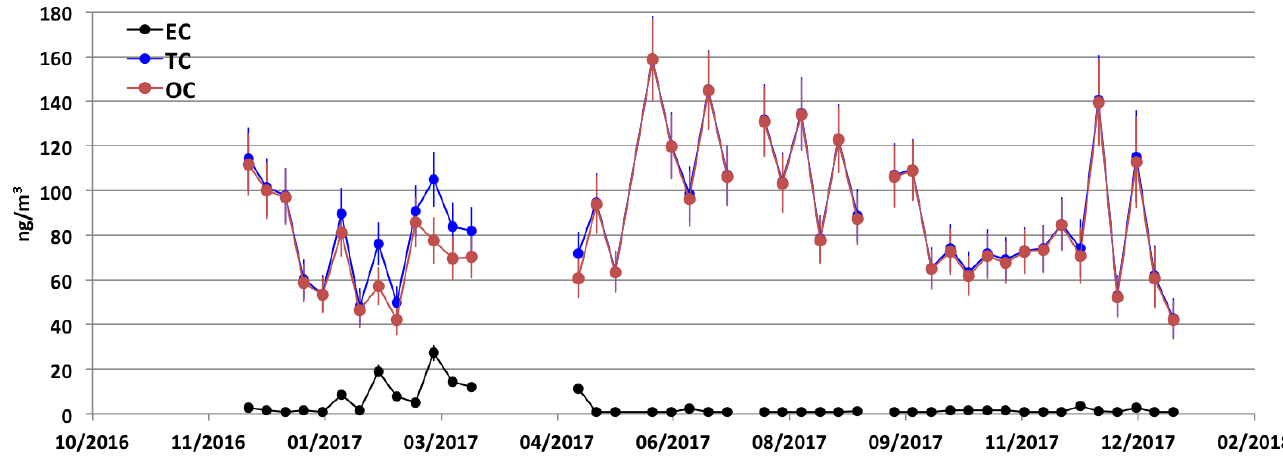
Figure 7. Concentration data set of OC, EC, and TC sampled in Dome C from 5 December 2016 to 15 January 2018. TC is represented with blue circles, OC with red circles, and EC with black circles. Error bars are calculated according to the text.